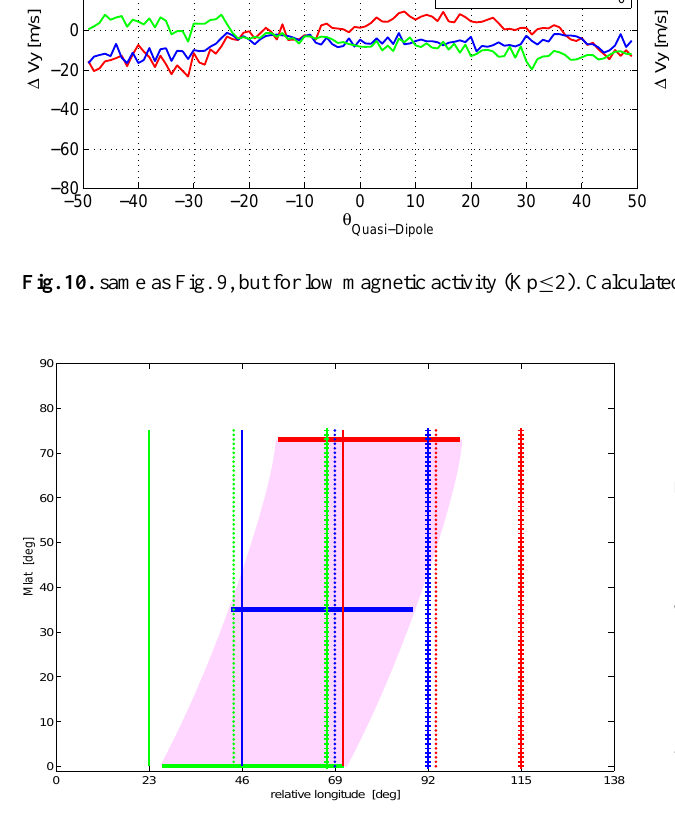
Fig. 11. Sketch of the longitudinal coverage by the various data subsets, selected by orbit sequence and bins. Red: 0.25–1.25h after substorm onset T 0 ; blue: 1.75–2.75h after T 0 ; green: 3.25–4.25h after T 0 . Solid lines: bin 1; dots: bin 2; crossed lines: bin 3. The pink background marks the path of the TAD front deflected by Cori- olis